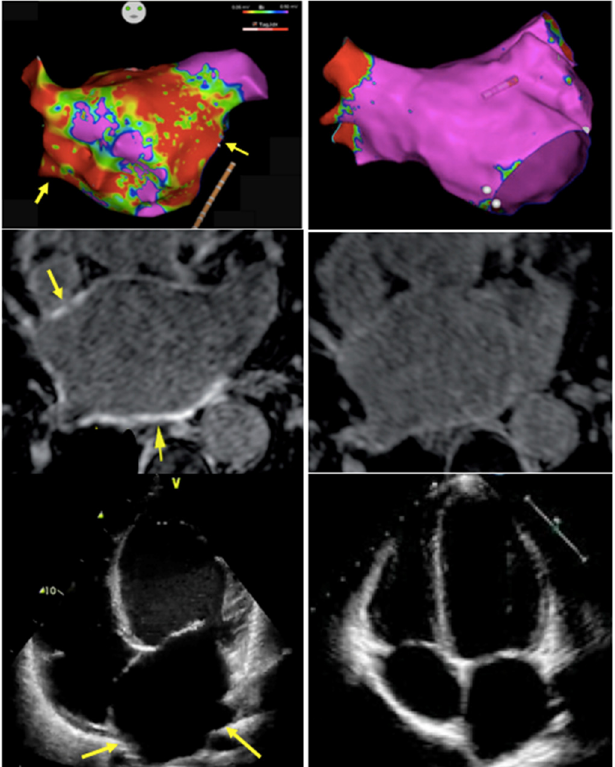
Figure 2. Substrate Severity: Multimodality assessment of the underlying atrial substrate to guide individualized treatment strategies. Figure 2 demonstrates three examples of severely diseased left atria compared to structurally normal ones. ( Top row ): Electro-anatomical voltage map of the left atrium: ( Left ) Left atrium with extensive scarring (red areas corresponding to bipolar voltage <0.05 mV, indicating scarring); ( Right ) Left atrium with normal “healthy” bipolar Voltage >0.5 mV (pink ar- eas). ( Middle row ) Atrial CMR images: ( Left ) late gadolinium enhancement (yellow arrows) within the anterior and posterior wall of the left atrium indicating fibrosis; ( Right ) no detectable LGE. ( Bottom row ) TTE Images Apical 4-chamber view: ( Left ) significantly enlarged left atrium; ( Right ) normal-sized left